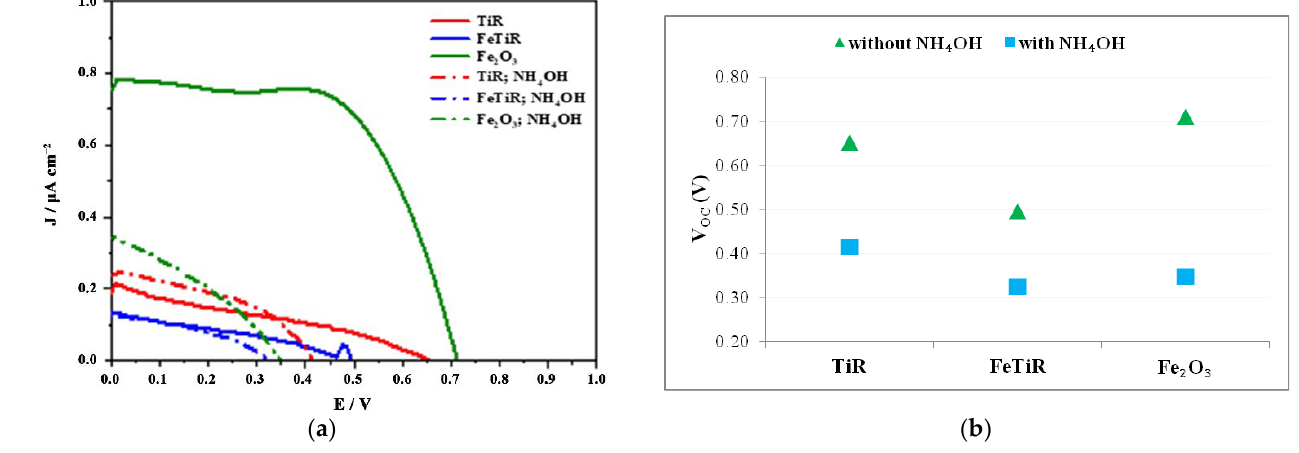
Figure 8. ( a ) J/V curves recorded for the investigated materials in pure electrolyte and diluted am- monia containing electrolyte under simulated solar irradiation; ( b ) V oc representation for the inves- tigated